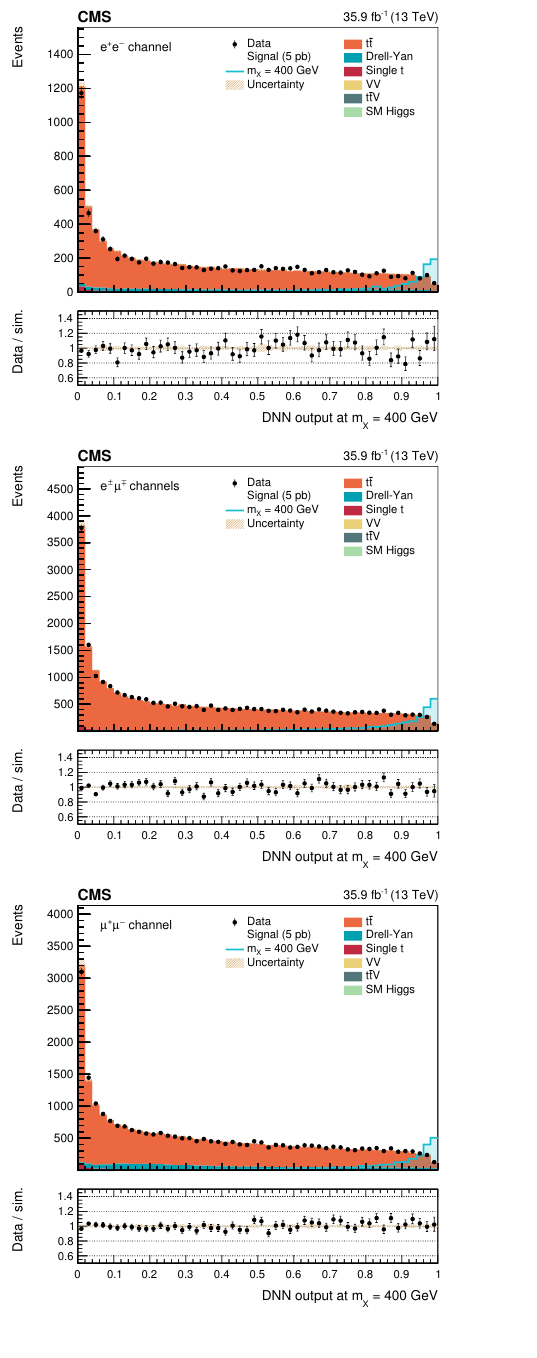
Figure 5 . The DNN output distributions in data and simulated events after requiring all selection criteria, in the e + e (cid:0) (top), e (cid:6) (cid:22) (cid:7) (middle), and (cid:22) + (cid:22) (cid:0) (bottom) channels. Output values towards 0 are background-like, while output values towards 1 are signal-like. The parameterised resonant DNN output (left) is evaluated at m X = 400 GeV and the parameterised nonresonant DNN output (right) is evaluated at (cid:20) (cid:21) = 1, (cid:20) t = 1. The two signal hypotheses displayed have been scaled to a cross section of 5 pb for display purposes. Error bars indicate statistical uncertainties, while shaded bands show post-(cid:12)t systematic